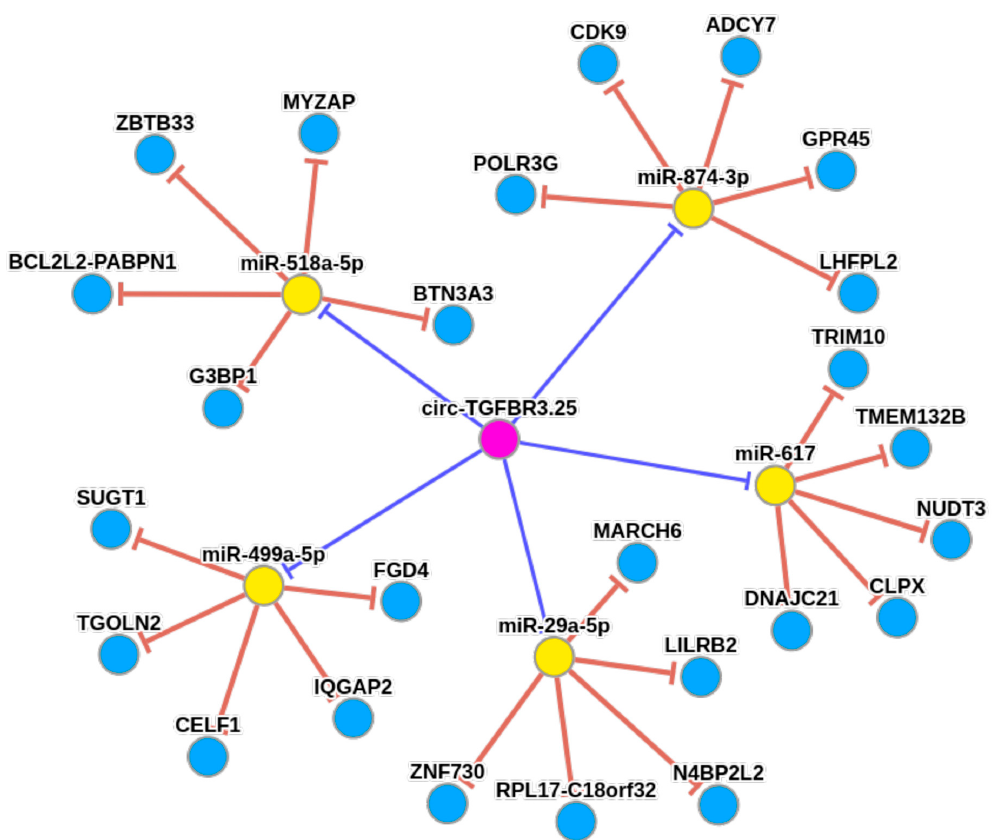
Figure 7. circ-TGFBR3.25 with sponge effect on miRNAs as predicted by CircNet. Yellow nodes represent miRNAs, blue nodes represent genes, and pink nodes represent circRNA. Red edges represent negative regulation of miRNA to the target gene; blue edges represent negative regulation of circRNA to